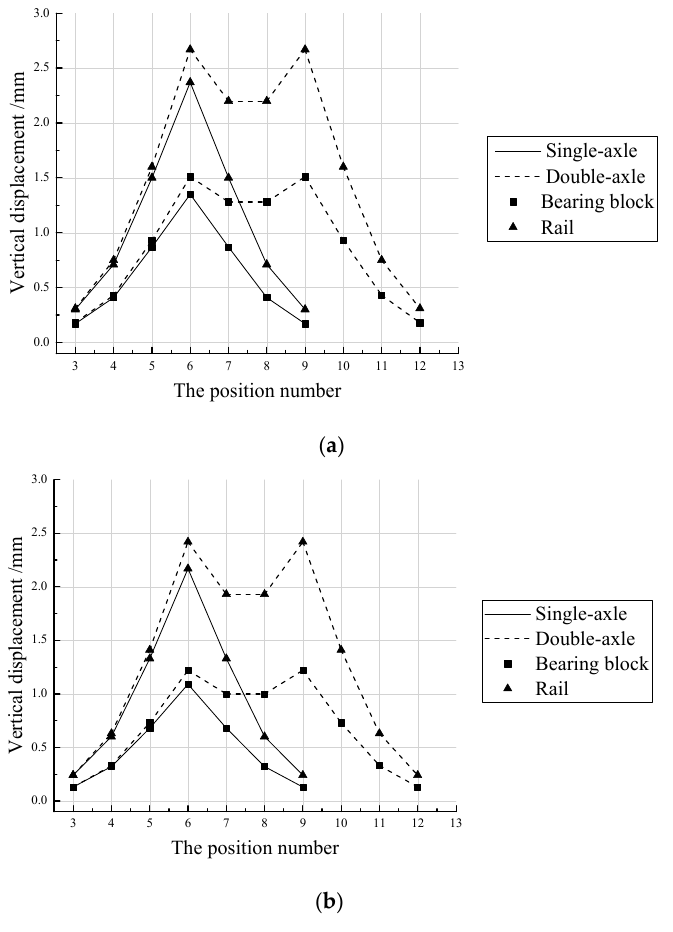
Figure 24. Vertical displacement of rail and bearing block under vertical load. ( a ) TLVT . ( b ) ILVT.